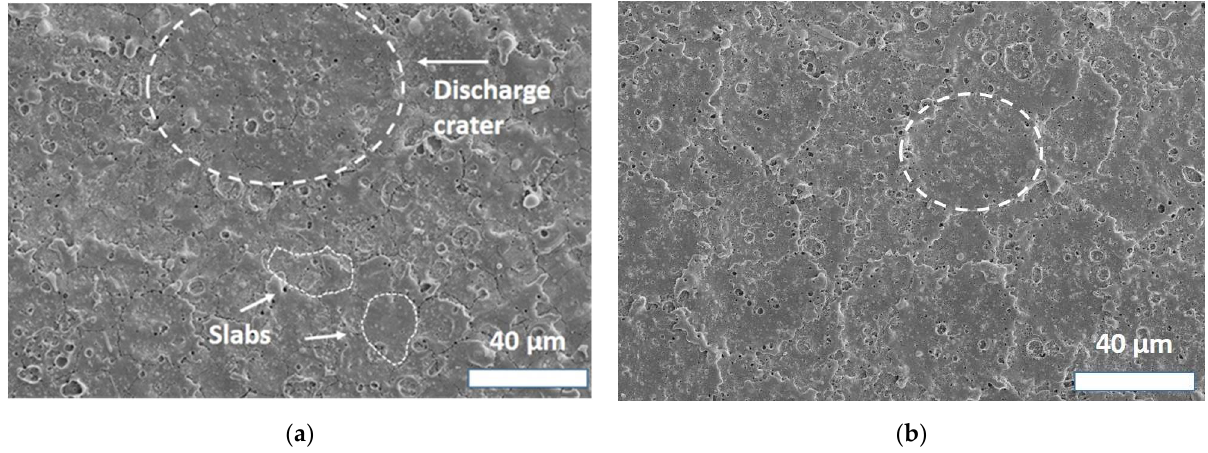
Figure 7. SEM images of ED-machined surfaces of 28 WC-1400. Dashed circles indicate size of discharge craters and the dotted line encircles slabs created by surface crack network. ( a ) 28 WC-1400 machined with parameter set EDM 1. ( b ) 28 WC-1400 machined with parameter set EDM 2.